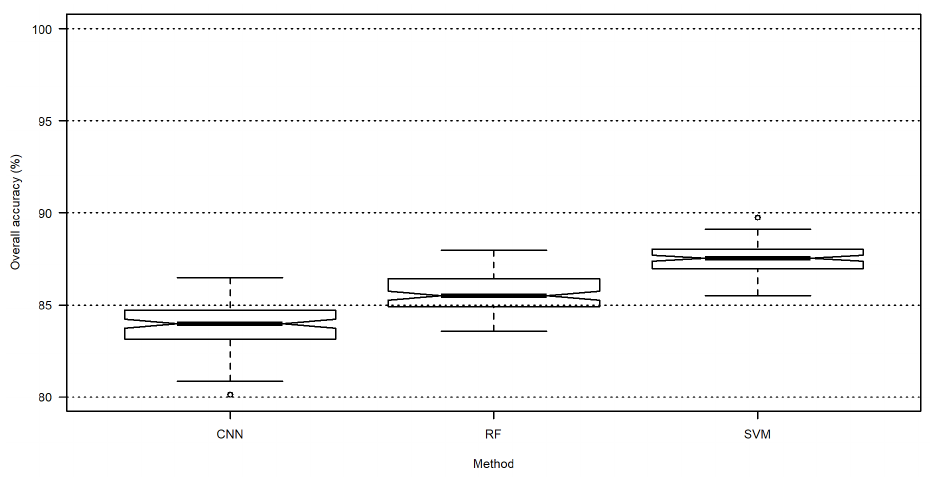
low (Figures 8 – 10) present the accuracies obtained for each classifier separately.